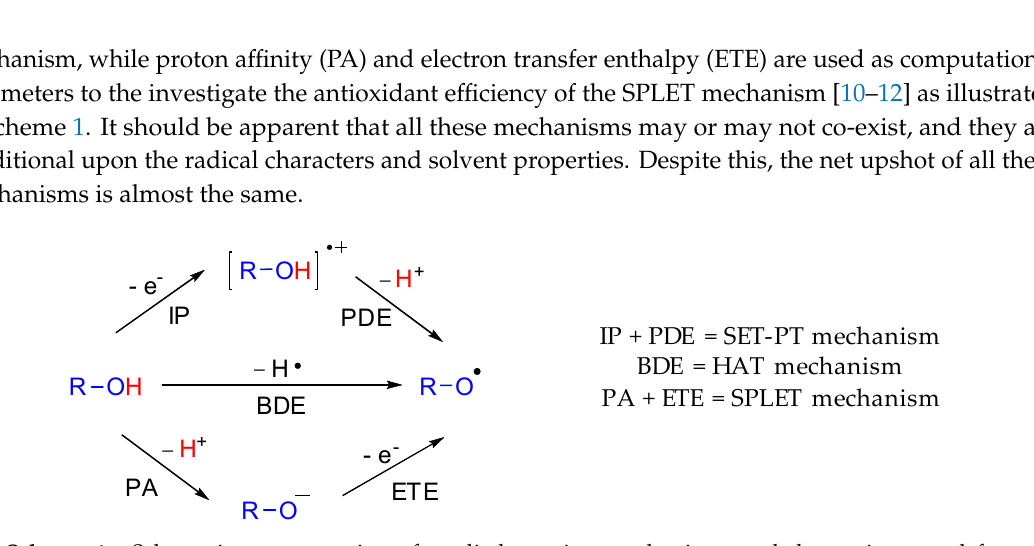
Scheme 1. Schematic representation of studied reaction mechanisms and denotations used for corresponding reaction enthalpies.